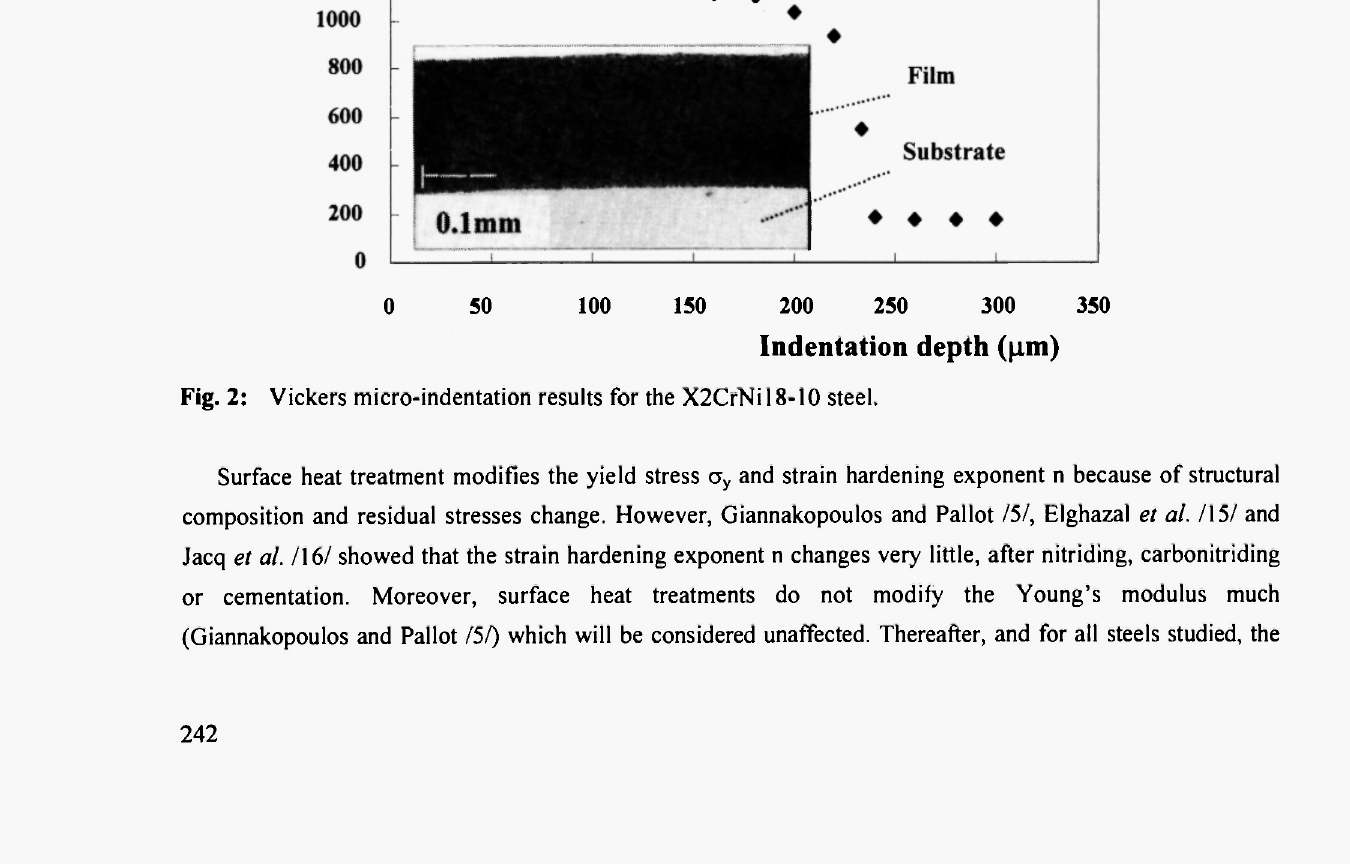
Fig. 1: Vickers micro-indentation results for the 40CrMnMo8 steel.